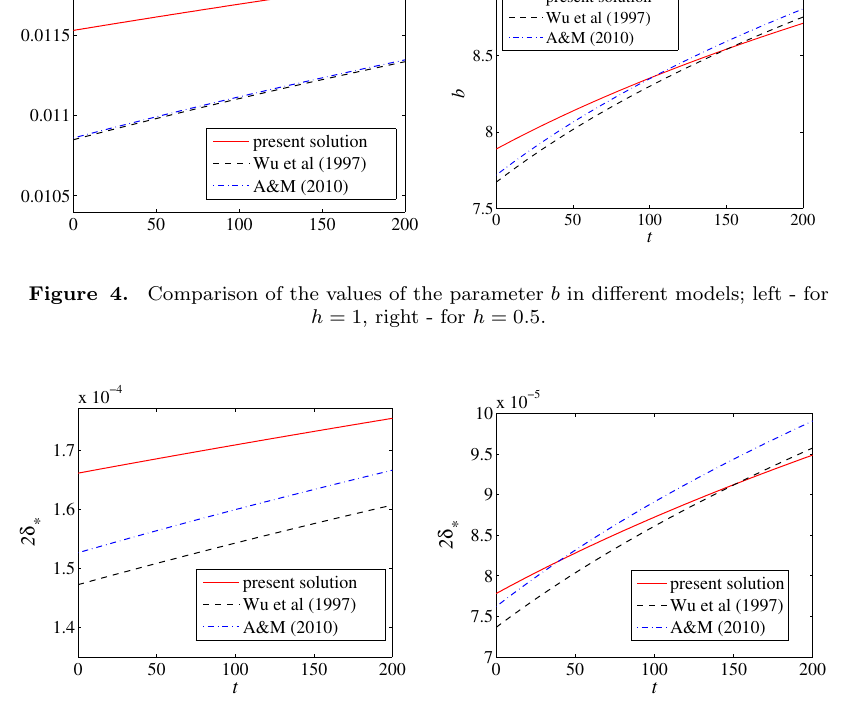
Figure 5. Comparison of the values of the parameter δ in different models; left – for h = 1, right - for h = 0 .